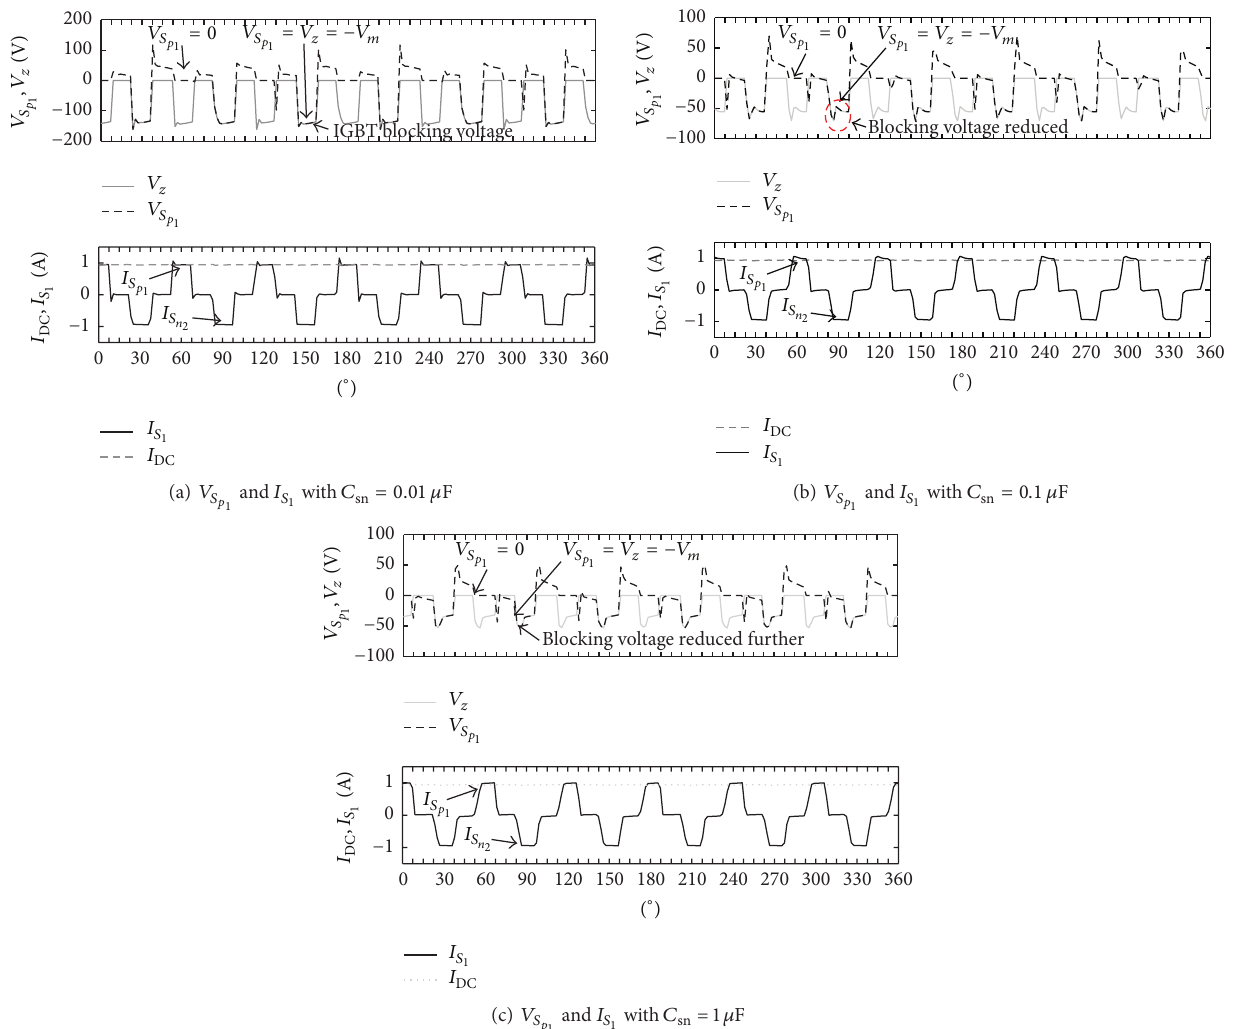
for different 𝐶 sn 1